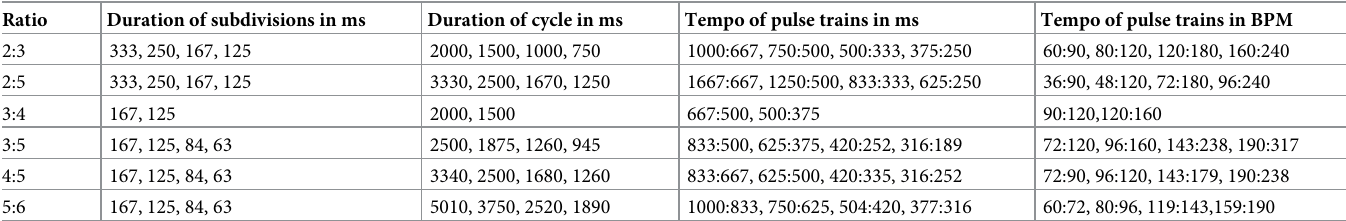
Table 2. The 22 stimuli of the ratio